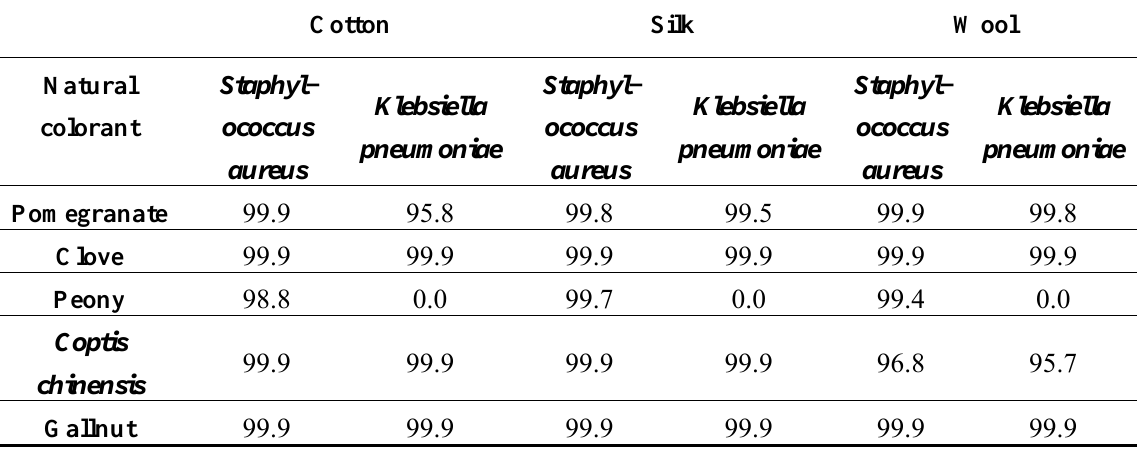
Table 2 . The bacteriostatic reduction rates (%) of cotton, silk, and wool fabrics dyed with peony, pomegranate, clove, Coptis chinensis and gallnut extracts against Staphylococcus aureus and Klebsiella pneumoniae .